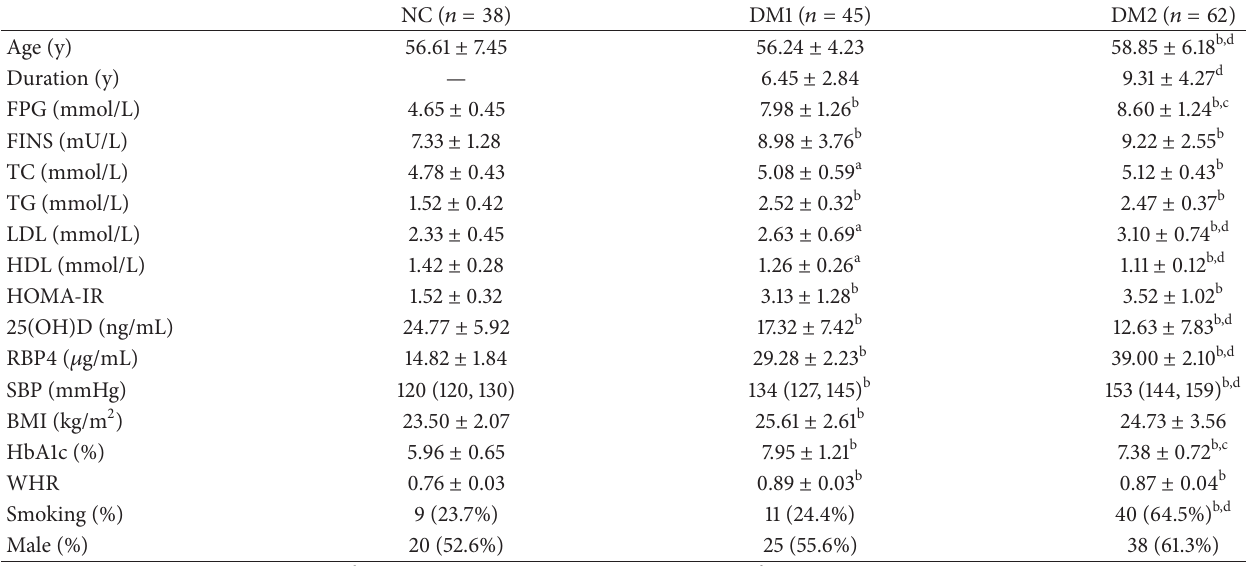
Table 1: The comparison of basic characteristics in Groups NC, DM1, and DM2.